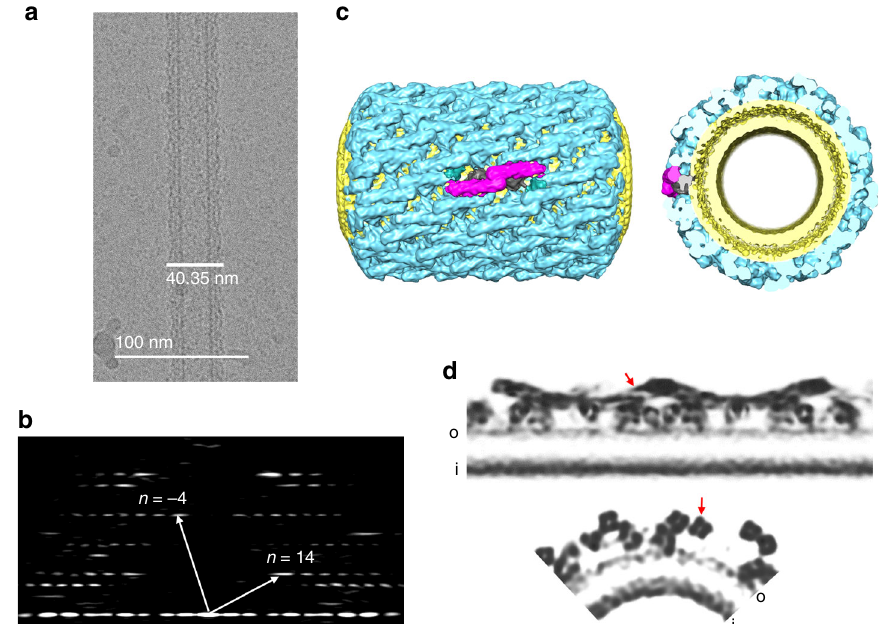
Fig. 1 Helical crystallization of the Syt1 C2AB – SNARE complex on the lipid membrane surface. a Cryo-electron micrograph of the Syt1 C2AB – SNARE complex helically organized on lipid nanotubes. A representative micrograph of ~41 nm protein-coated LNTs with homogenous helical packing used in the reconstruction is shown. b Corresponding Fourier Transform of the LNTs shows a helical diffraction pattern with the Bessel functions for basis vectors, which corresponds to Δ z = 7.35 A Δφ = 78.48; 14, − 4 start helix. c Iso-surface representation of the helical reconstruction of protein-coated LNTs at 10.4 Å resolution. The Syt1 C2AB -SNARE protein (blue) is arranged on the lipid bilayer tube (yellow) with characteristic rod-like densities (magenta) corresponding to the SNARE complex oriented almost parallel to the tube axis and thus, locally experience a relatively fl at bilayer surface. d Grayscale density slice through the one side of the 3D-volume along the helical axis (top, slice depth 1) and quarter grayscale slice from cross-sectional density (bottom, slice depth 30). The densities corresponding to α -helices forming the SNAREpin (red arrow), as well with phospholipid heads plane of the inner (i) and outer (o) membrane lea fl ets are also well de fi